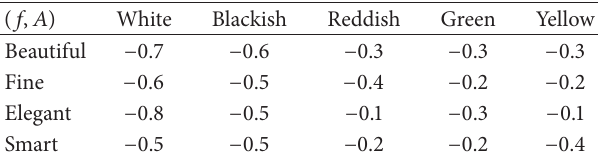
Table 9: Tabular representation of (𝑓,𝐴) .